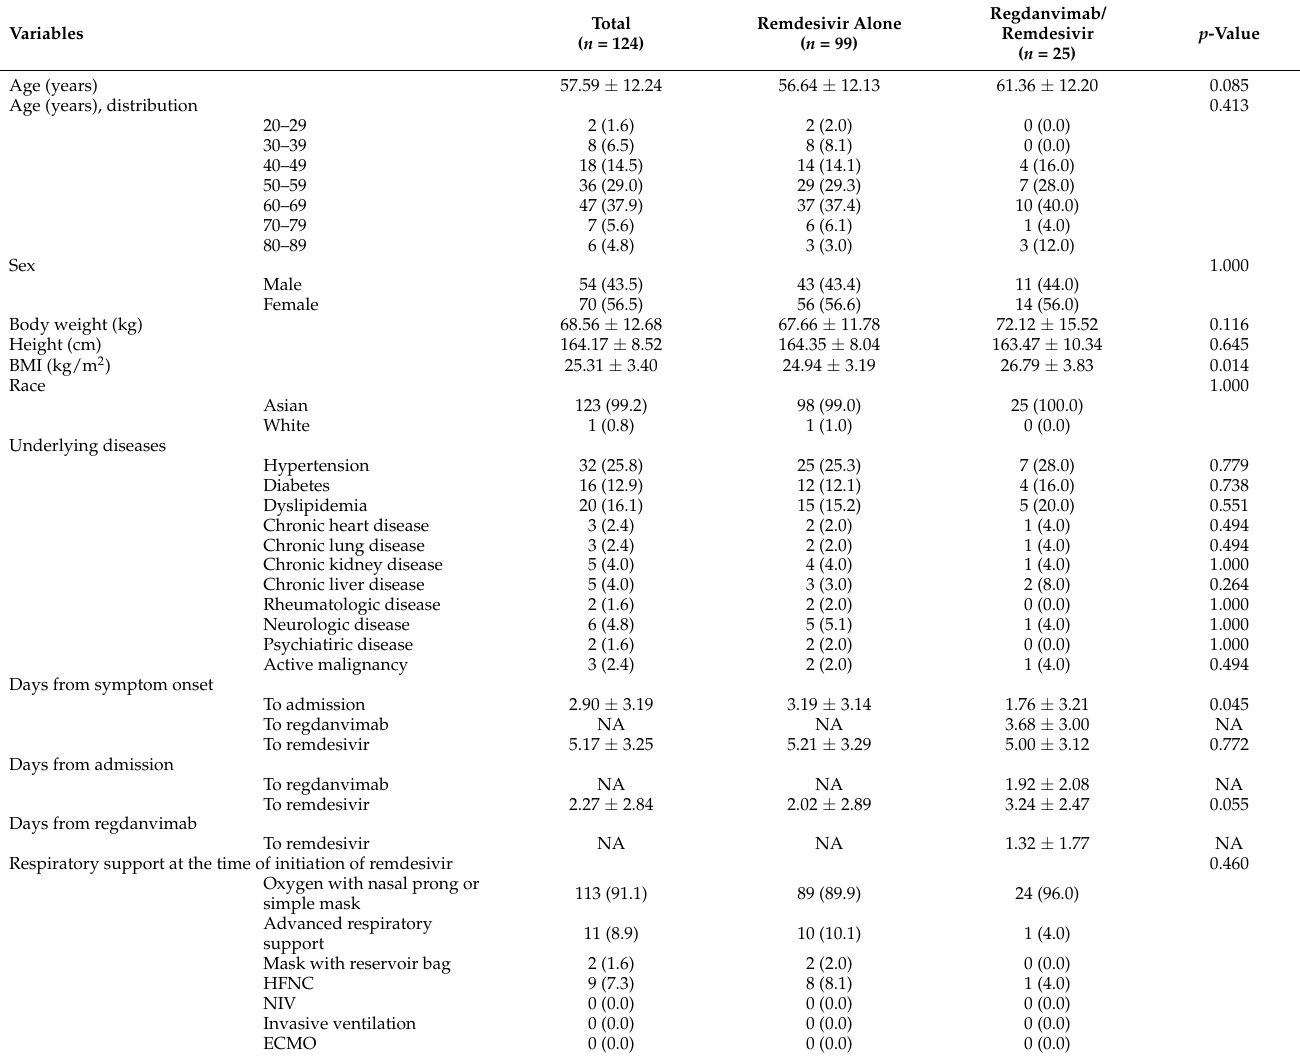
Table 1. Baseline characteristics at initiation of remdesivir